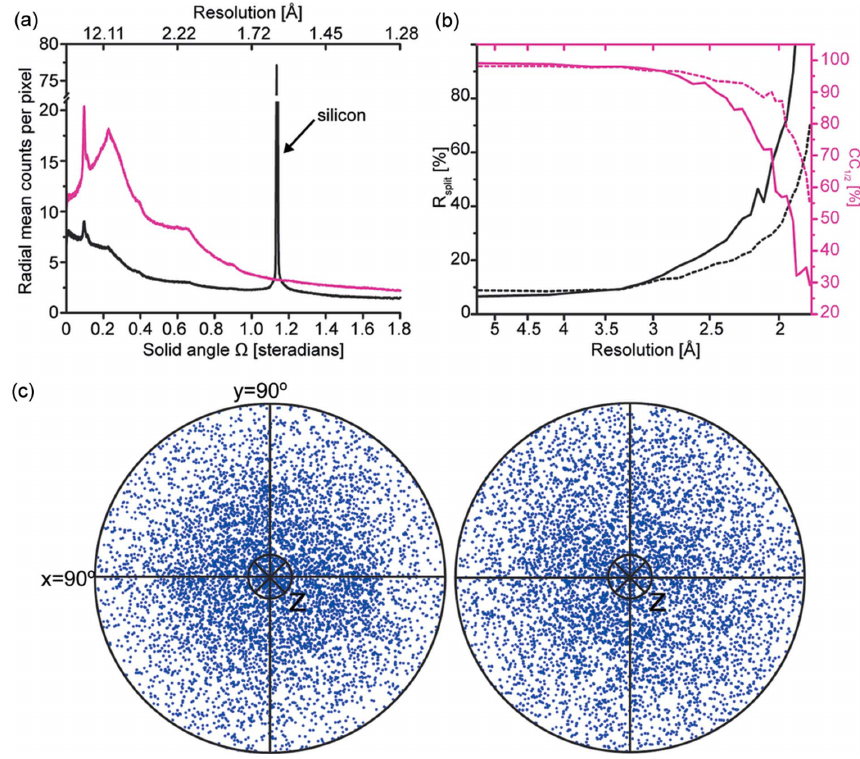
Figure 3 Analysis of VioC data. ( a ) Normalized average background count for anaerobic (magenta) and air- exposed setups (black) resulting from (cid:5) 3.0 (cid:6) 10 10 photons at 12.8 keV with a beam size of 8 (cid:6) 8 m m. ( b ) R split (black) and CC 1/2 (magenta) plotted against the resolution for anaerobic VioC:Fe:2OG (solid line) and O 2 -exposed VioC:Fe:succinate (dashed line) datasets. The analysis was done for 10200 randomly selected integrated frames. ( c ) Stereographic projections illustrating the crystal orientation of 6400 randomly selected crystals for air-exposed VioC:Fe:2OG (left) and anaerobic VioC:Fe:succinate (right) datasets. The plots represent the direction of the hkl 001 of each crystal relative to the beam direction ( z ). For data collected on chips, the direction of hkl 001 to <45 (cid:4) movement away from the beam direction seems to be favoured.